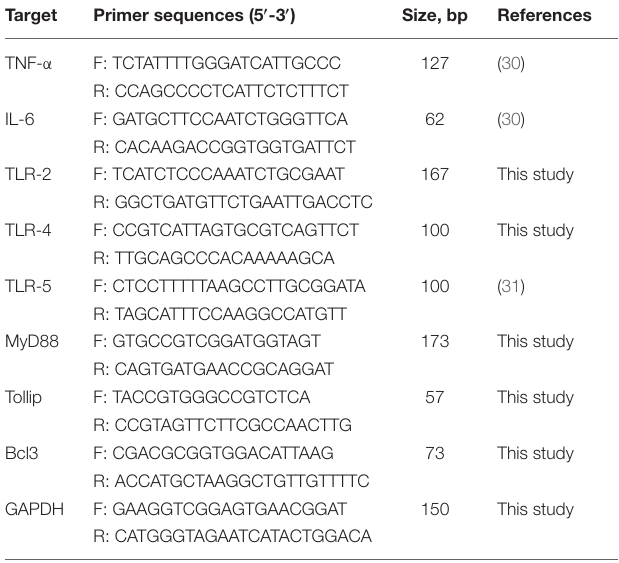
TABLE 2 | Primer for real-time PCR.